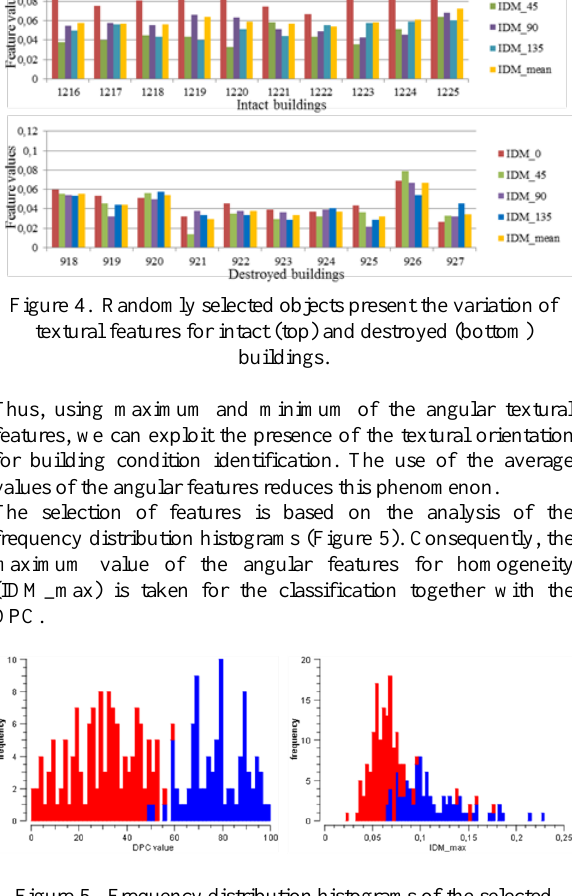
Figure 5. Frequency distribution histograms of the selected features. Red values correspond to destroyed buildings, blue values to intact buildings.